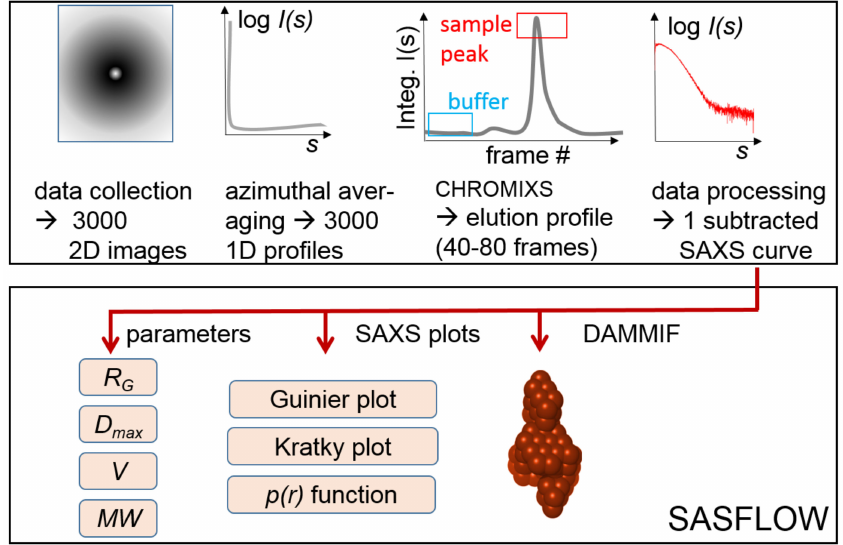
Figure 2. Overview of the automated analysis procedure for SEC-SAXS data collected at